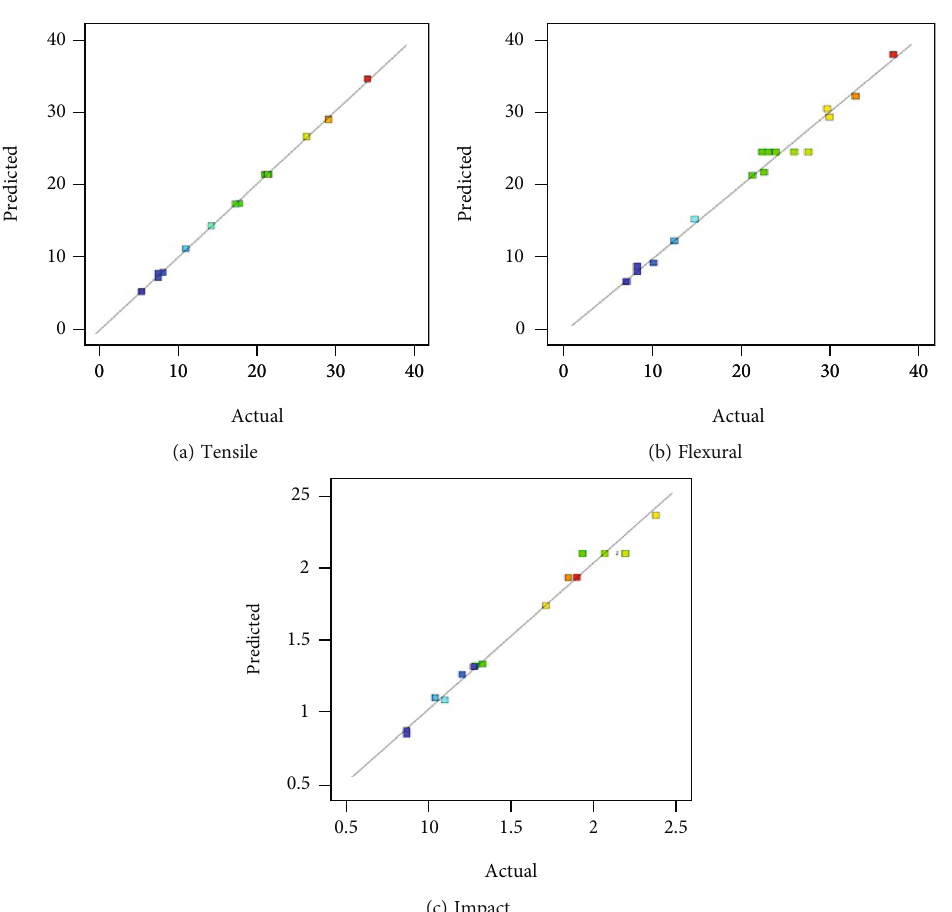
Figure 8: Predicted vs. actual value of (a) tensile, (b) fl exural, and (c) impact strength of CGF- and hemp-based hybrid composites. Table 5: CGF- and hemp-based activated carbon adsorbents characteristics ( n = 3 ). Sample BET surface area (m 2 /g) Micropore surface (m 2